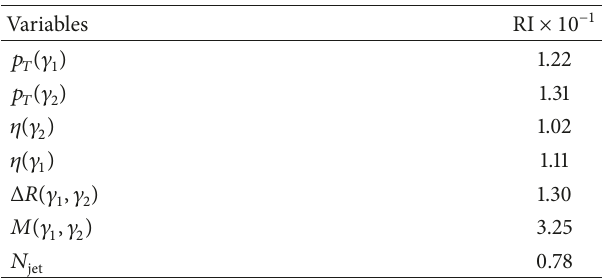
Table 2: Input variables used for MVA to separate the signal from the background and their relative importance (RI). These numbers are shown for 𝑀 S = 1